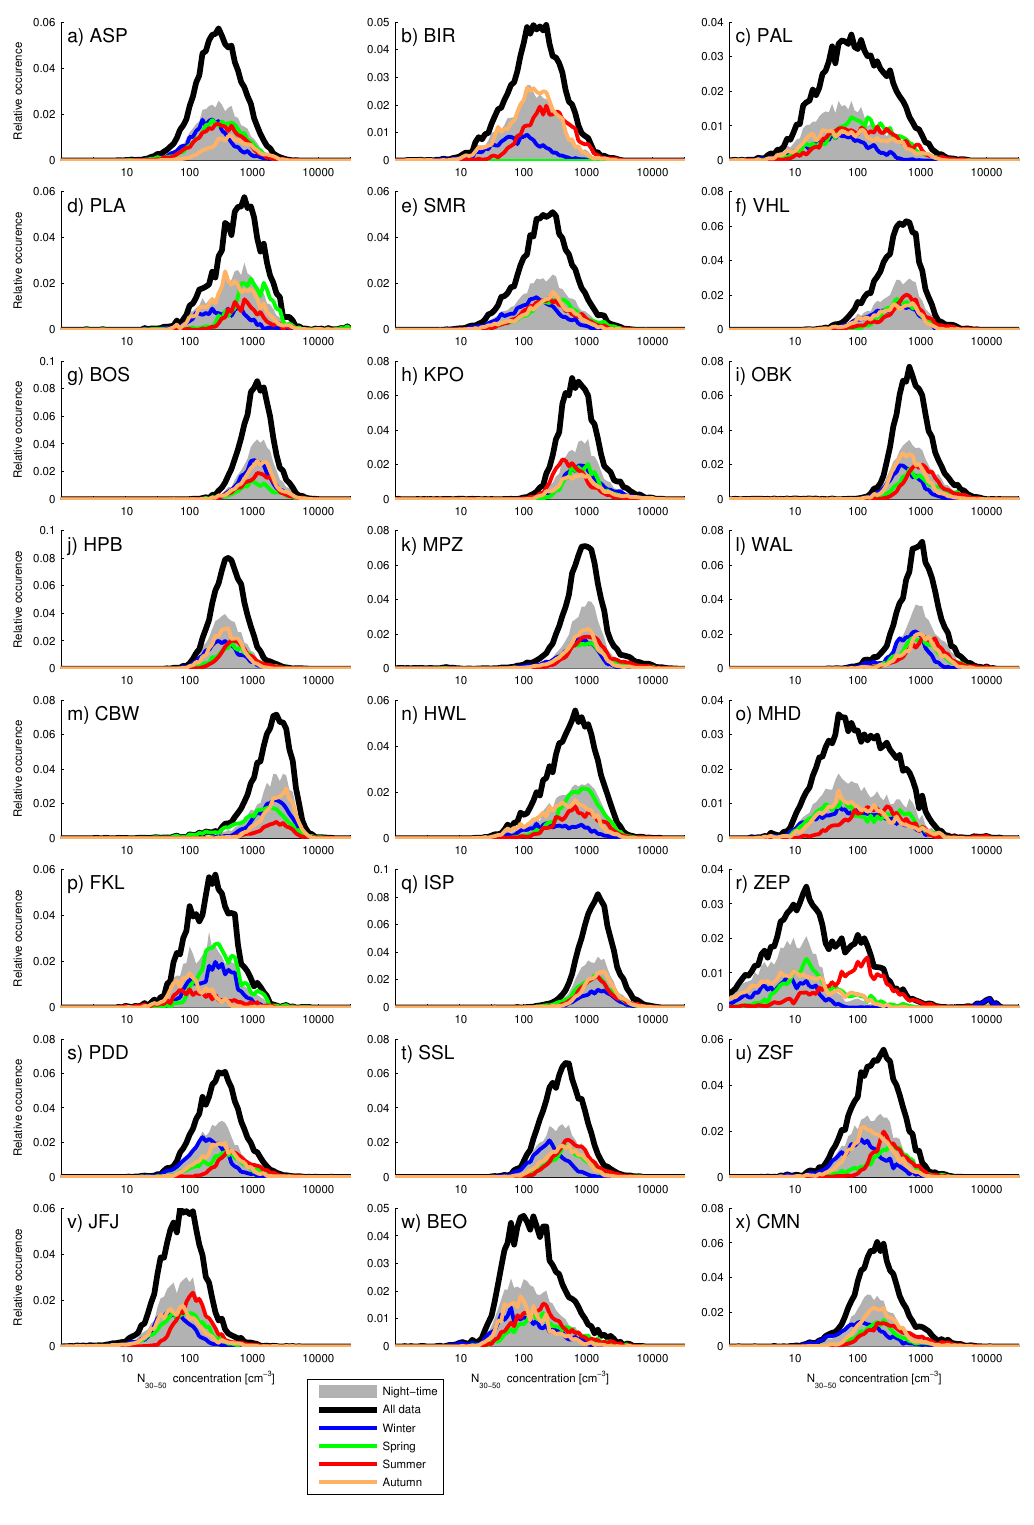
Fig. 9. Histograms of N 30 − 50 concentrations at the stations. The concentration bins are evenly distributed in the concentration axes (20 bins/decade) and the y-axes of the figures show the fraction of the values in each bin compared to total number of valid